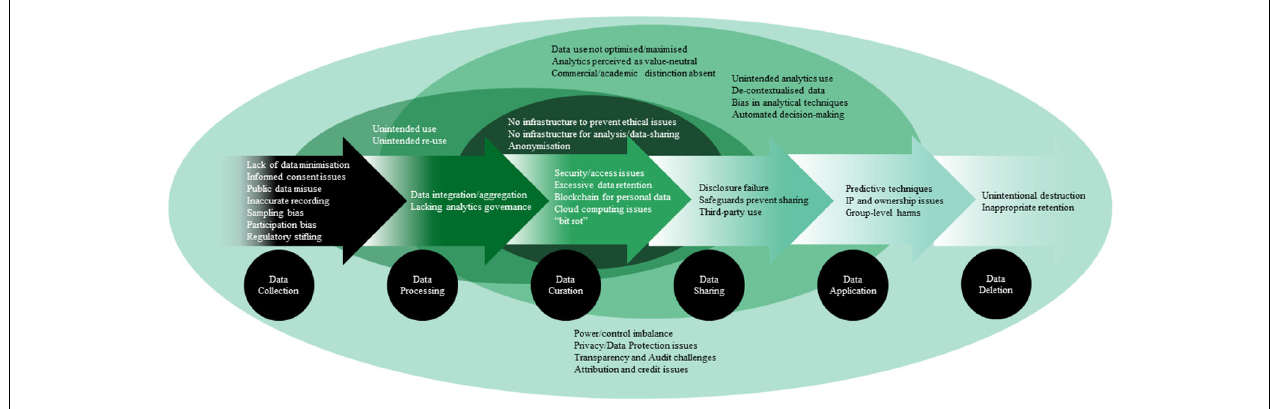
FIGURE 2 | Ethical issues and the overlapping stages at which they may arise in the data